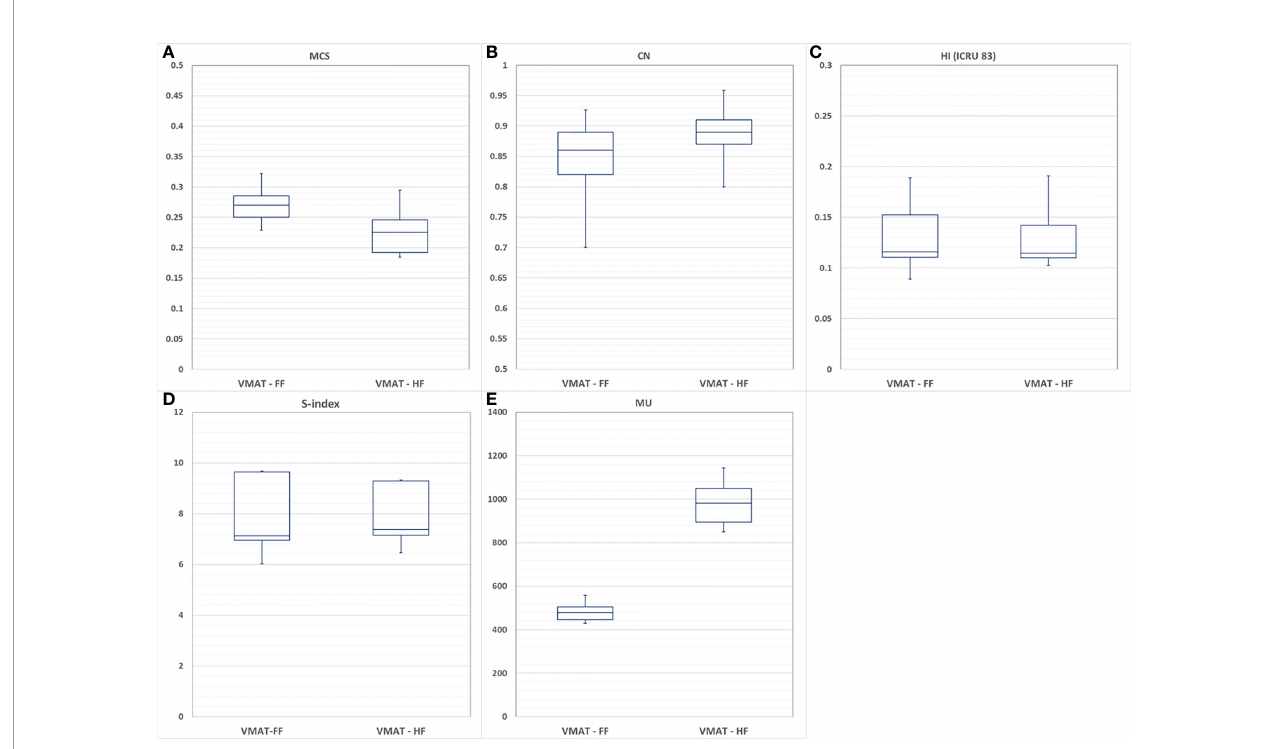
FIGURE 4 | Comparison of volumetric modulated arc therapy (VMAT) optimized with using a fully opened fi eld (VMAT-FF) and a half-beam technique (VMAT-HF) with (A) modulation complexity score (MCS), (B) conformity number (CN), (C) homogeneity index (HI), (D) s-index, and (E) monitor units (MU).